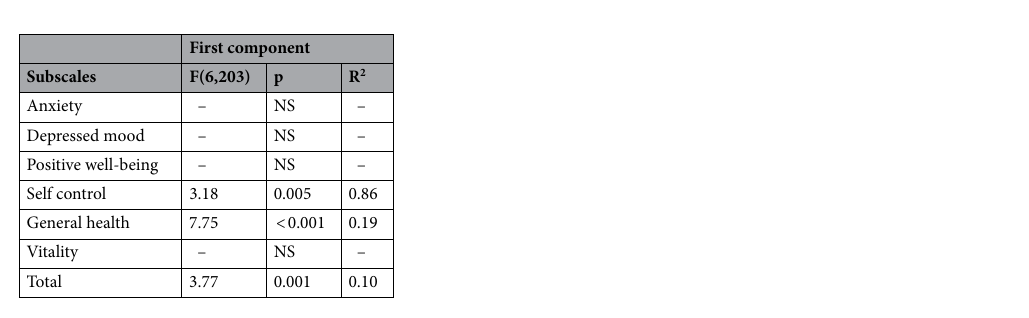
Table 4. Regression analysis of the first component on the different subscales and the total score in the study population. NS not